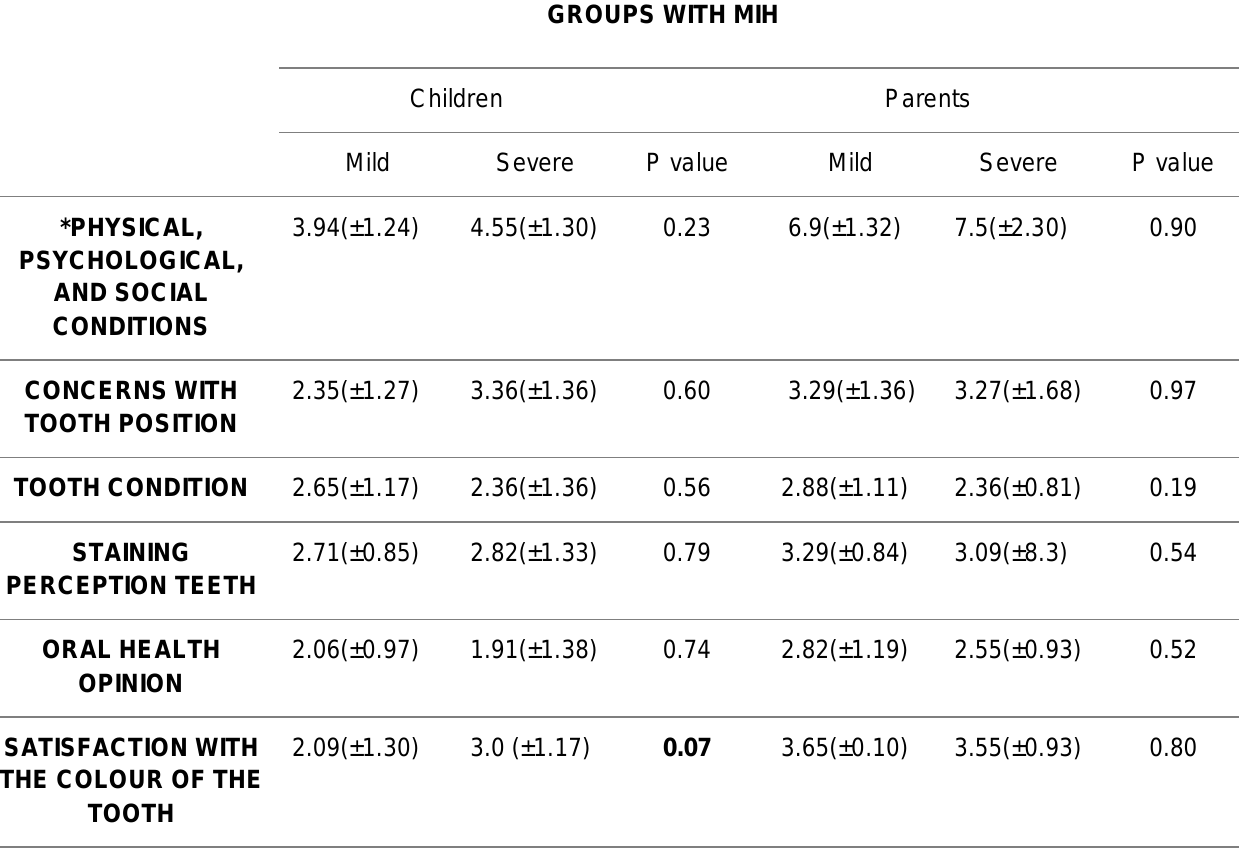
TABLE 4. Evaluation of agreement between parents/children (MIH group) for aesthetic perception and psychosocial conditions accord into level of